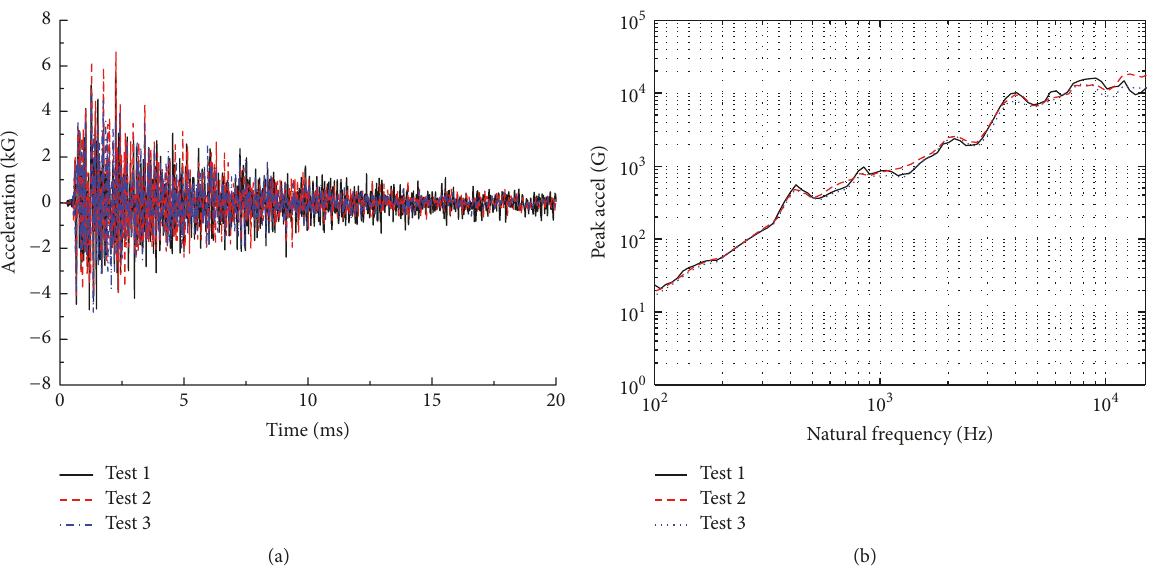
Figure 9: Comparison of three test results of explosive bolts in state 2: (a) acceleration time history and (b) shock response spectrum.